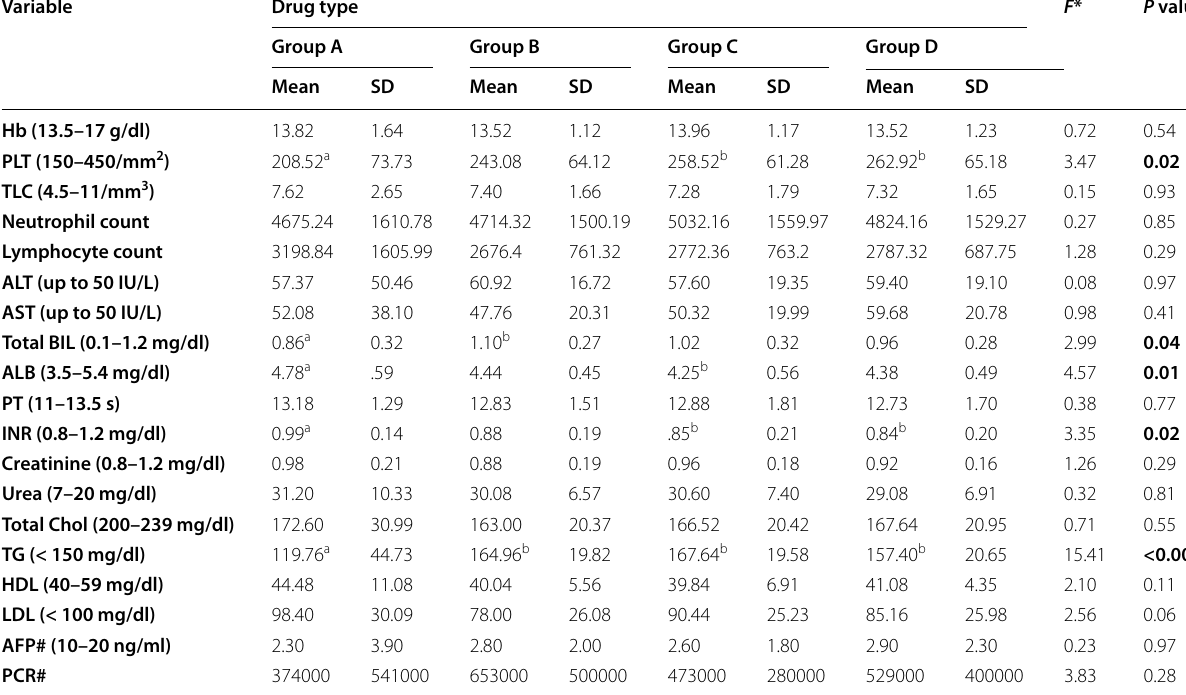
Table 3 Laboratory investigations for the study groups before